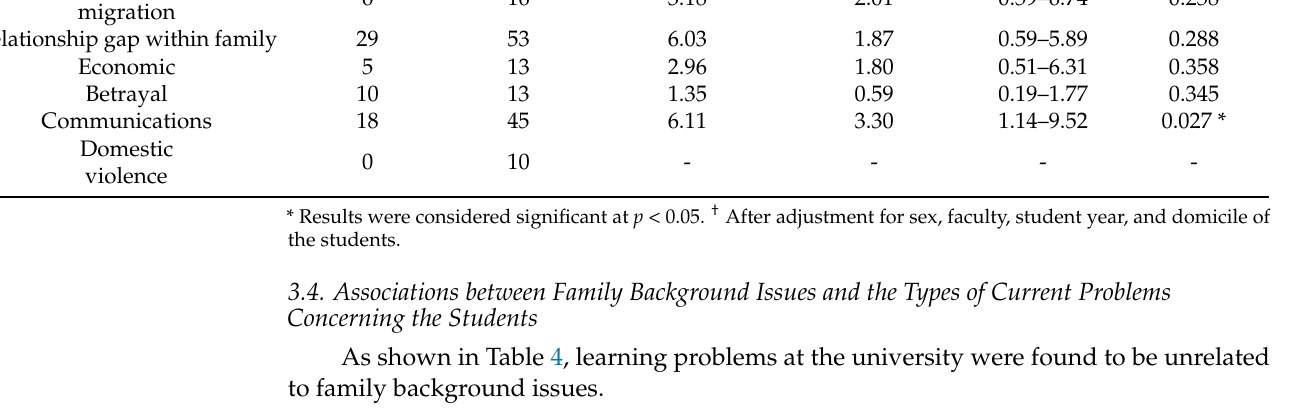
Table 4. Associations between family background issues and current problems concerning the